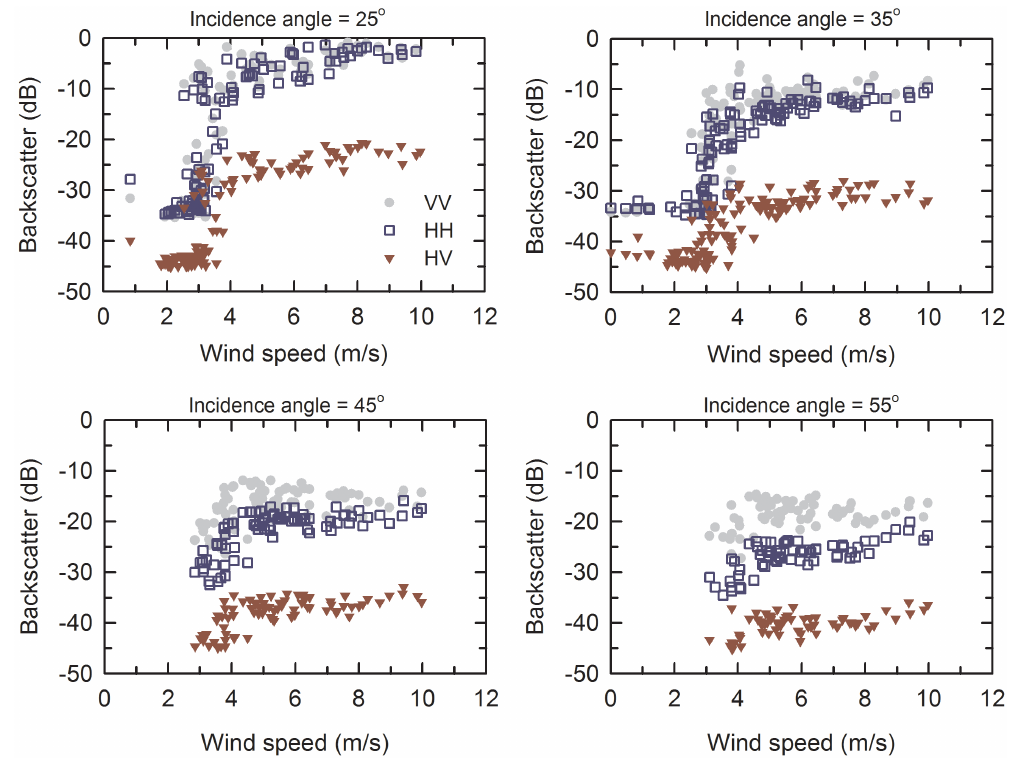
Figure 5. VV, HH and HV polarisation backscatter versus wind speed ( U 10 ) at 10 ◦ incidence angle intervals from 25 to 55 ◦ . Samples are from Database